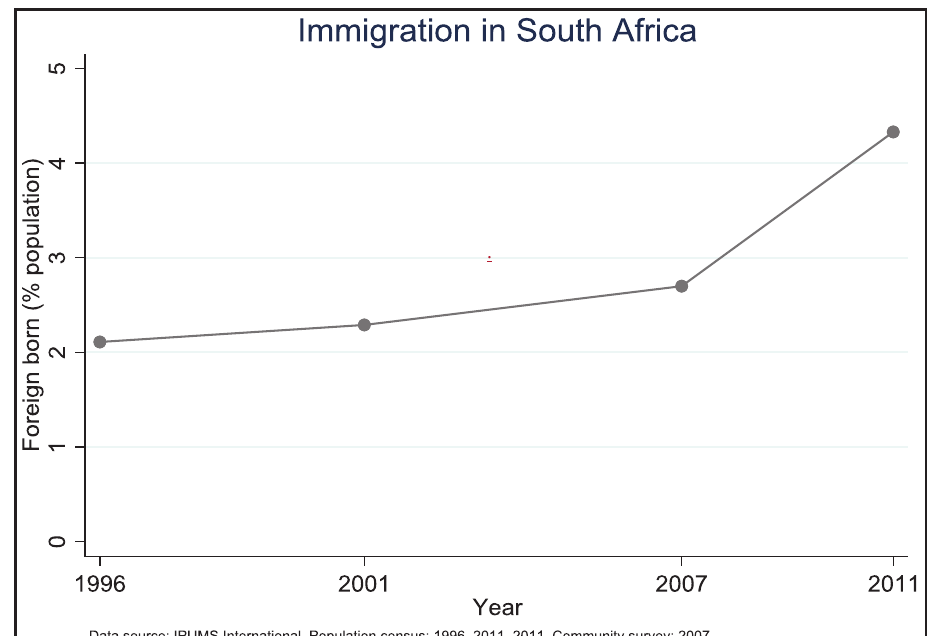
Figure 1 Immigration in South Africa.